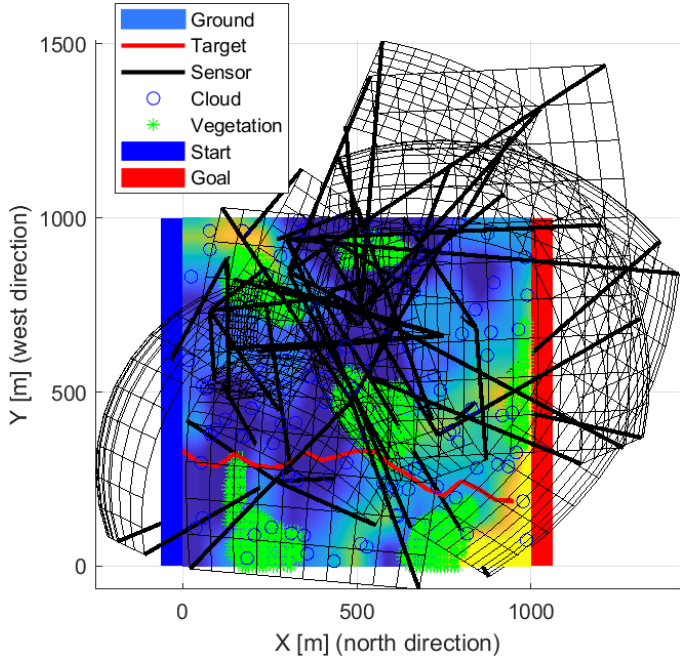
Figure 20. The solution in the case of the thirteen sensors from above.